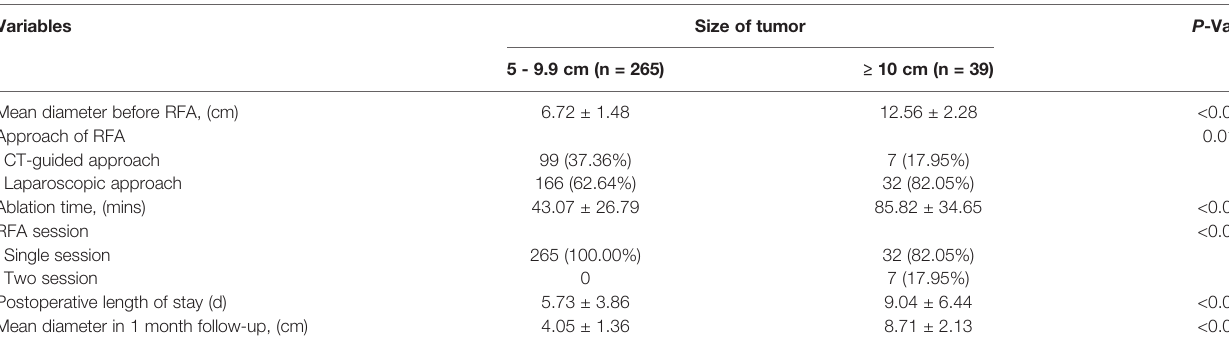
TABLE 3 | RFA for 304 hepatic hemangiomas.